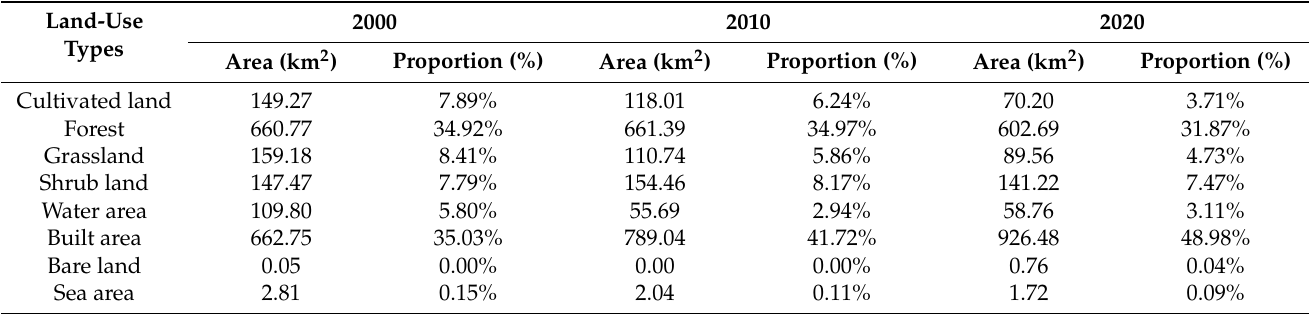
Figure 3. Land-use types of Shenzhen City in ( a ) 2000, ( b ) 2010, and ( c ) 2020. Table 4. Distribution of land-use types in three periods.